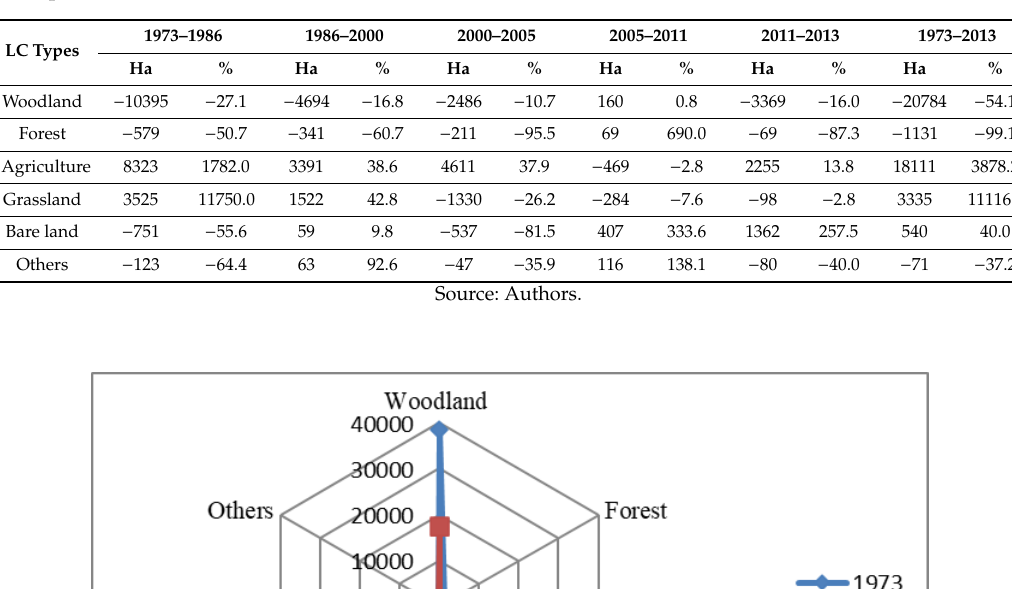
Table 5. Land cover change in hectare and percentages of the change for each land cover class between the periods indicated.